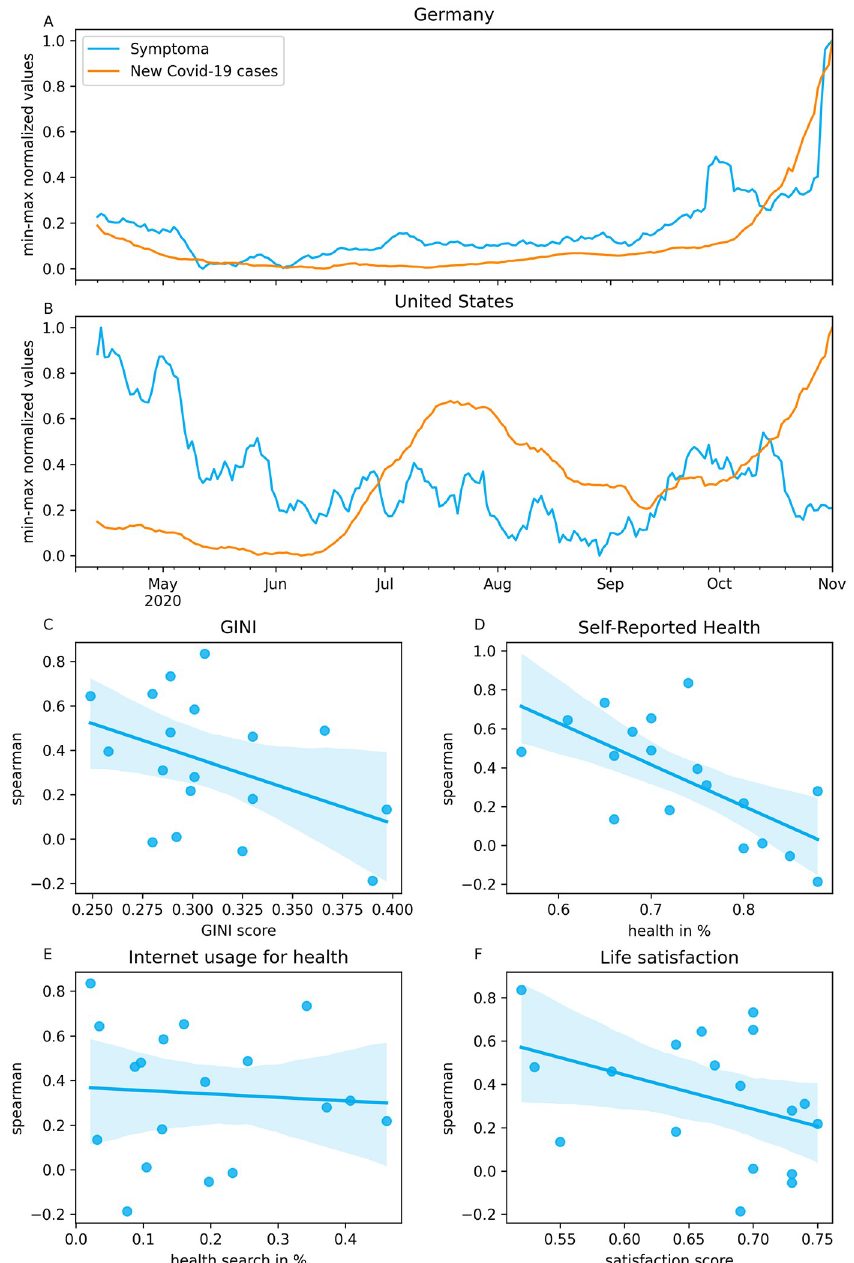
Fig 1. Correlation analysis between COVID-19 cases and Symptoma risk assessment. (A), (B) Comparison of COVID-19 cases and Symptoma risk assessment over time for Germany and the United States. (C)—(F) Scatterplot between the spearman correlation coefficients and various QOL measures per